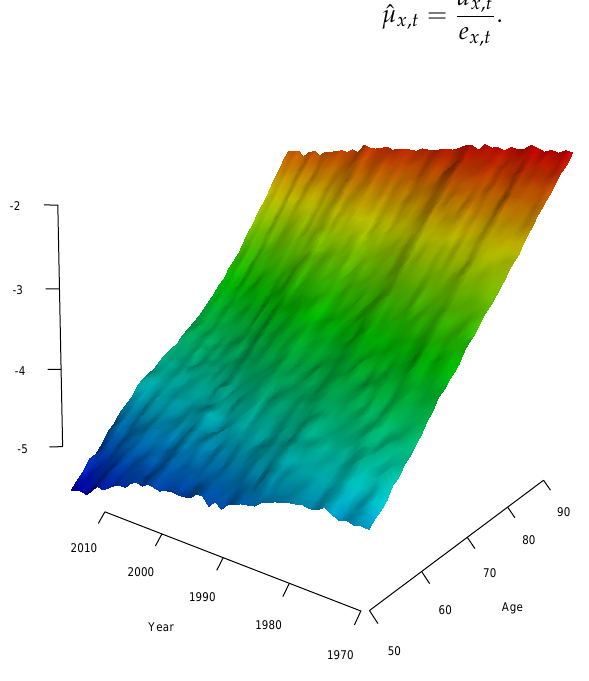
Figure 1. Surface of the logarithm of the raw death rates for age from 50 to 90 and year from 1970 to 2017 for French